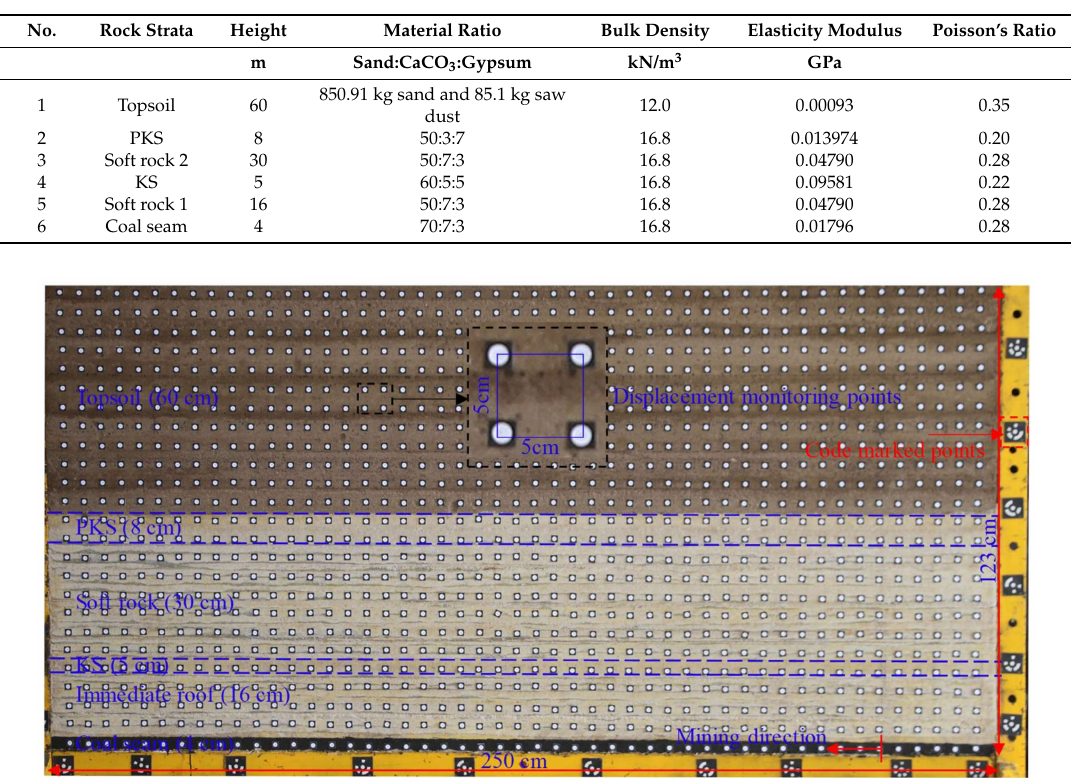
Table 1. Physical model size and material ratios.